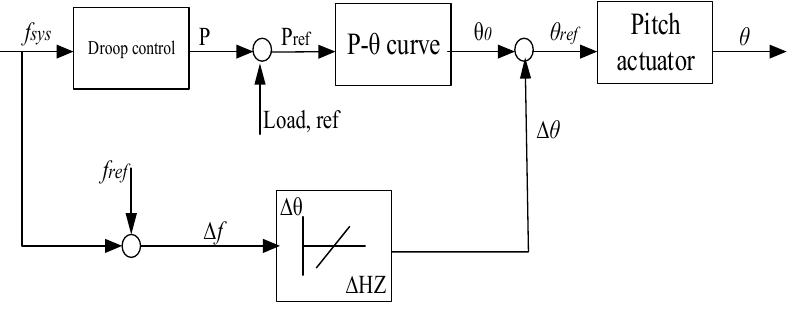
Figure 20. Pitch control schematic.